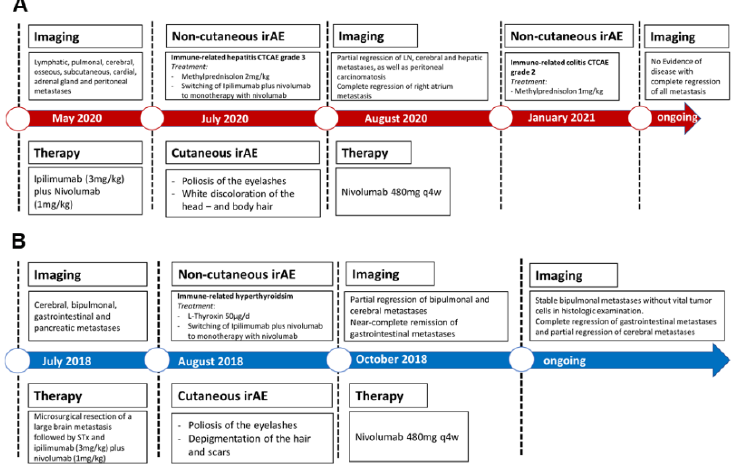
Figure 2. Schematic timelines of therapy, imaging and the occurrence of cutaneous and non-cutaneous adverse events in the course of the disease of patient #1 ( A ) and #2 ( B ).